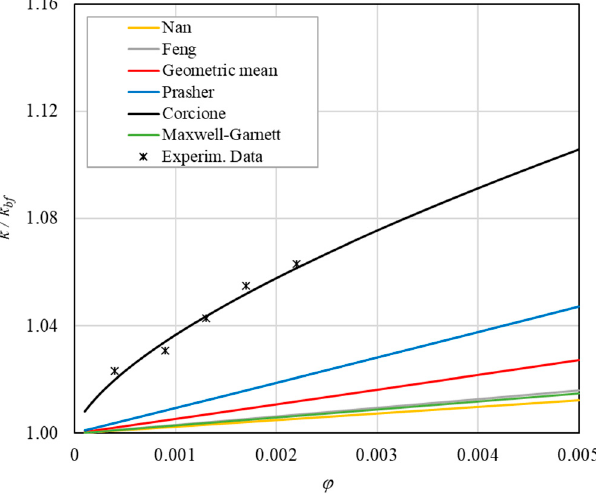
Figure 12. Increase in thermal conductivity versus volumetric content for engine oil (Castrol Magnatec 10W40)—Alumina (d = 50 nm) at 50 °C.